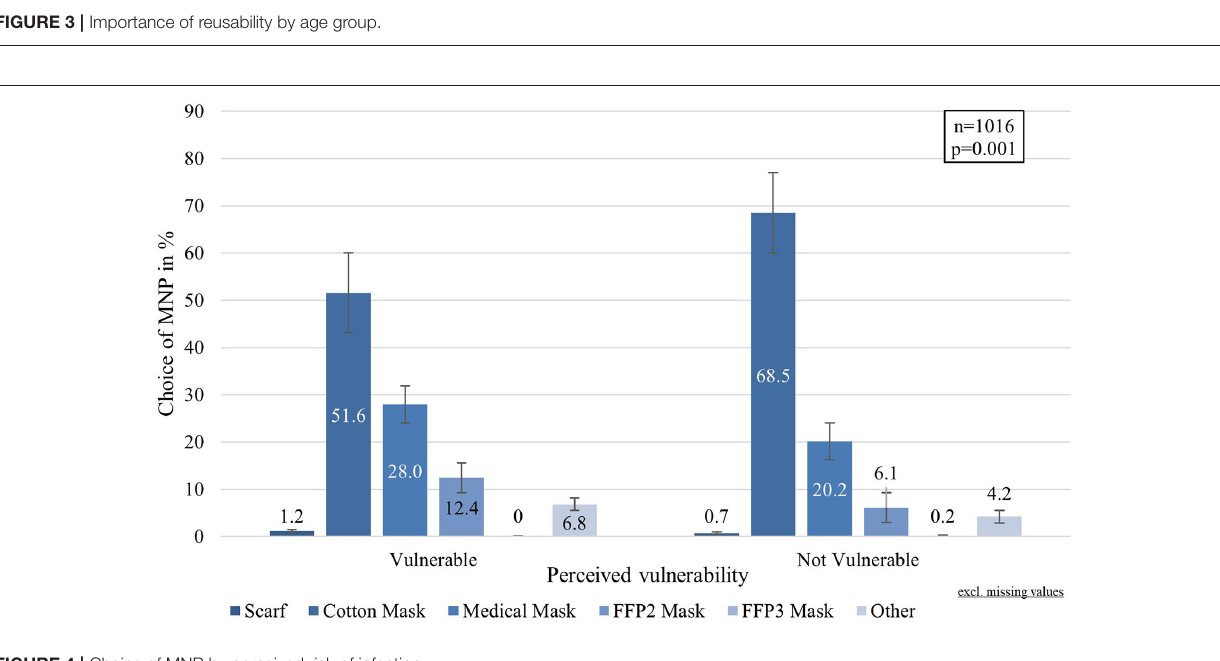
FIGURE 4 | Choice of MNP by perceived risk of